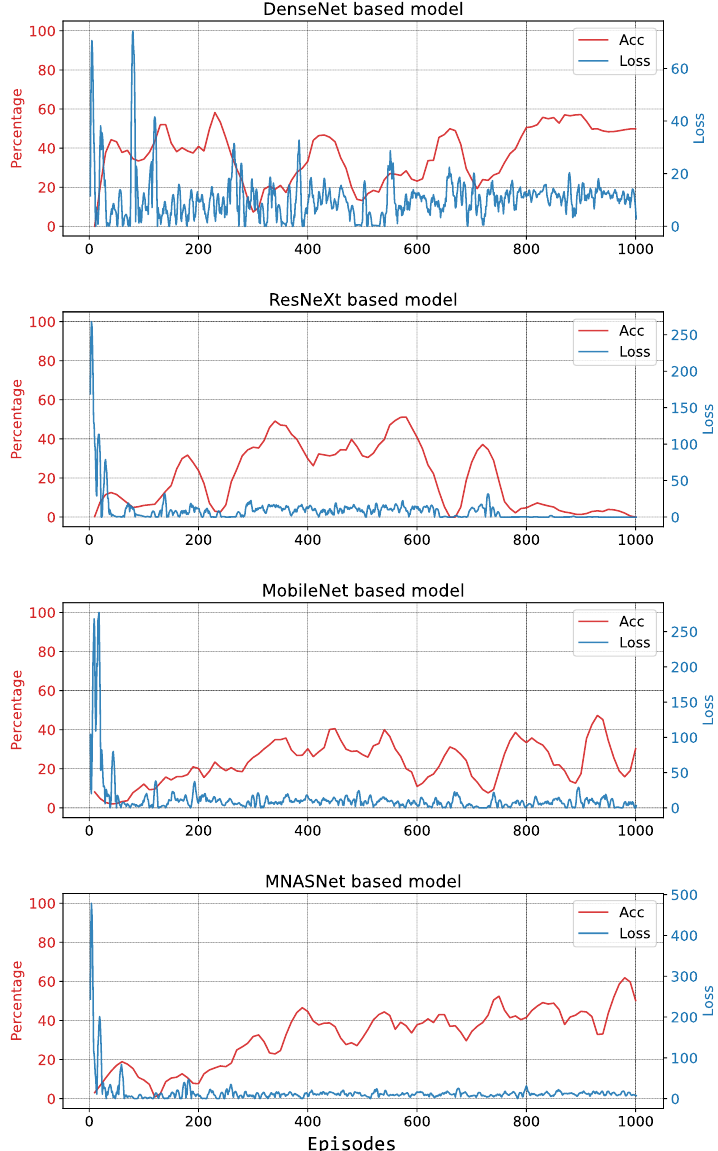
Figure 7. Evolution of loss and accuracy during 1000 episodes of the first training session. For all models, loss remains low while there is no sustained improvement in accuracy. The blue line shows loss data smoothed using a third order